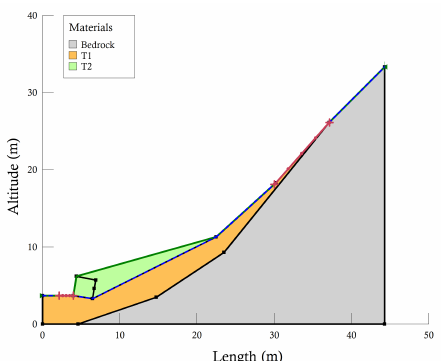
Figure 9. Model used to simulate the presence of the double-walled wooden piling.